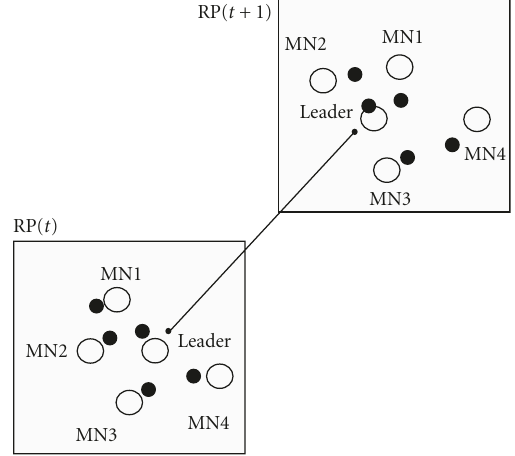
Figure 3: Example: a group of five mobile nodes movements using the RPGM model.